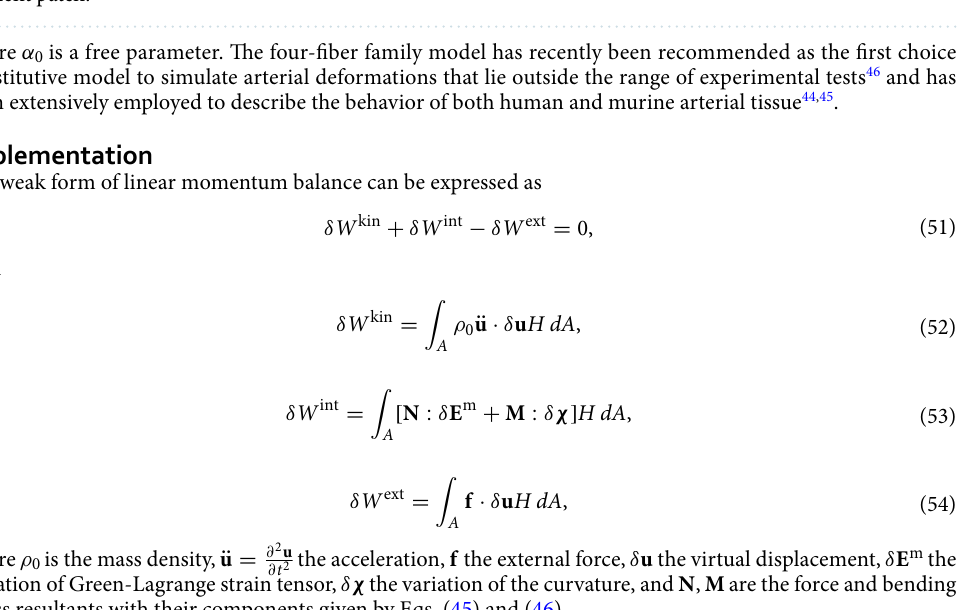
Figure 2. Schematic of the element patch comprising a master element and three adjacent elements in ( A ) spatial coordinates and ( B ) natural coordinates. ( C ) Plots of the six quadratic shape functions defined over the element